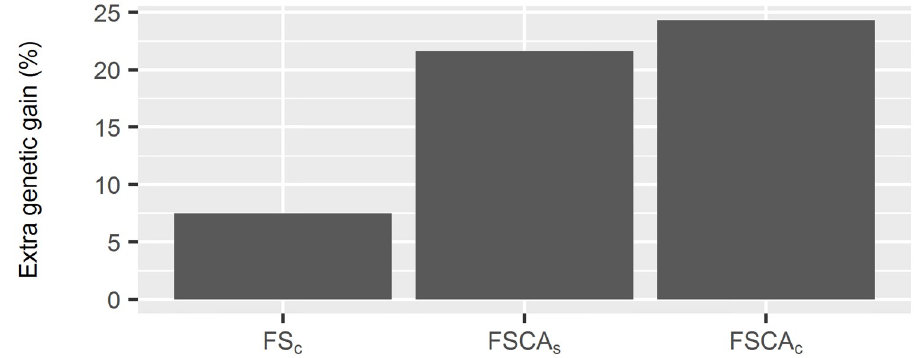
Fig 6. Additional genetic gain per year from FSCA when deployed as seedlings (FSCA s ), or clones (FSCA c ), when compared with deployment of selected individuals from FS via seedlings (FS s ).